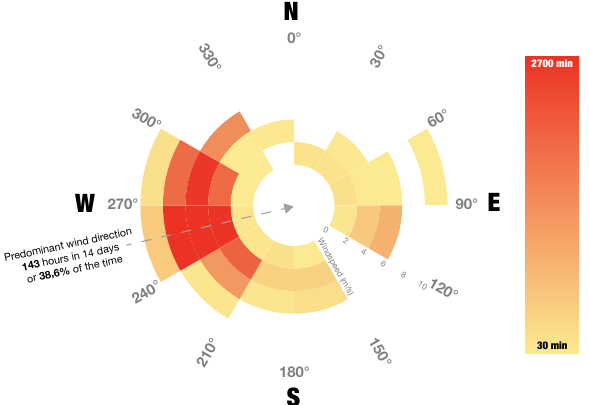
Figure 6. Wind direction and wind speed have a huge impact on the distribution of particle matter (PM). This wind rose (also known as a coxcomb chart) shows the predominant wind direction and the time of different wind speed in the period from 25/06/2019 to